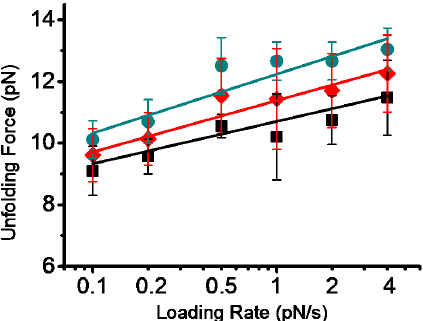
Fig. 2. The loading rate-dependent unfolding forces of (cid:1) -CM M2 and M3 domains. Black squares show the mean unfolding force of the ¯rst unfolding step, while cyan circles show the mean unfolding force of the second unfolding step. Red dia- monds give the average unfolding force of these two domains. Each data point is obtained from average of at least 24 mea- surements. The error bar denotes the standard deviation of unfolding force at each loading rate. The solid lines denote linear ¯tting results.